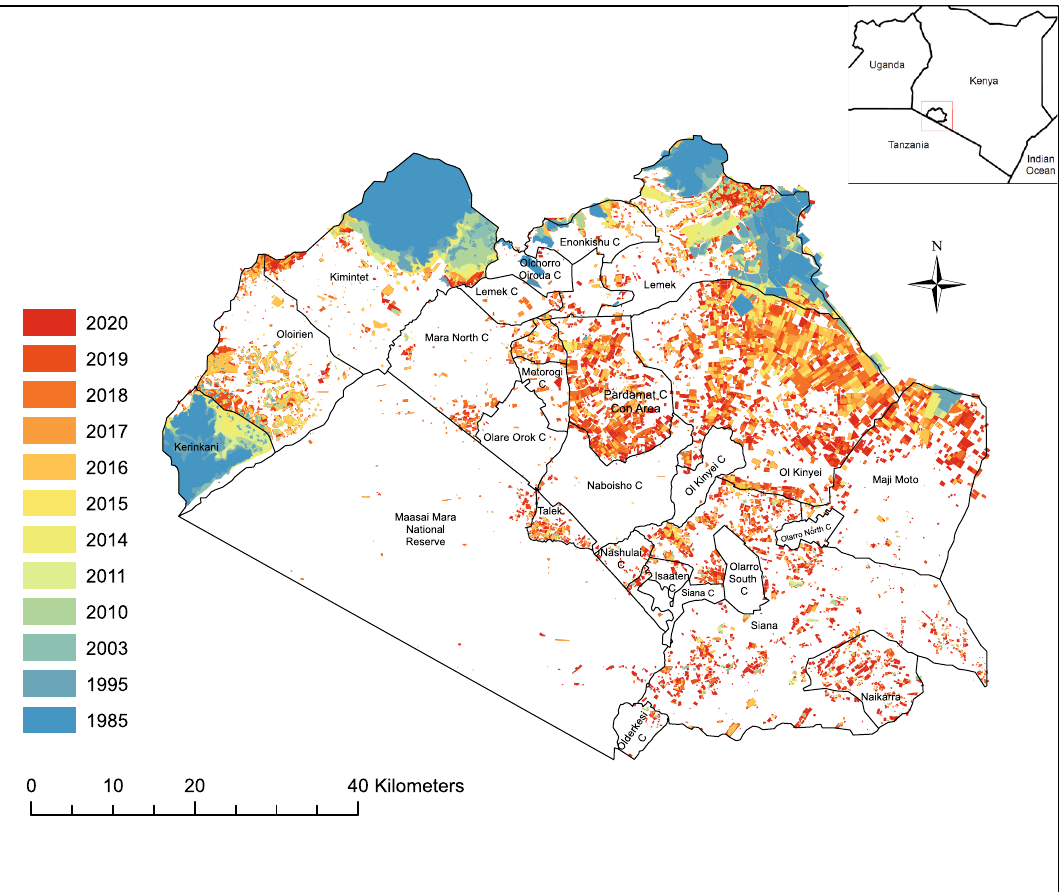
Figure 1. Fences in the Greater Mara, Kenya (1985–2020). Based on a systematic digitization of the fences from Landsat and Sentinel from 1985 to 2016 7 and 2017–2020 using ArcMap (vs. 10.6.1). Fences are indicated on a sliding color scale described by the